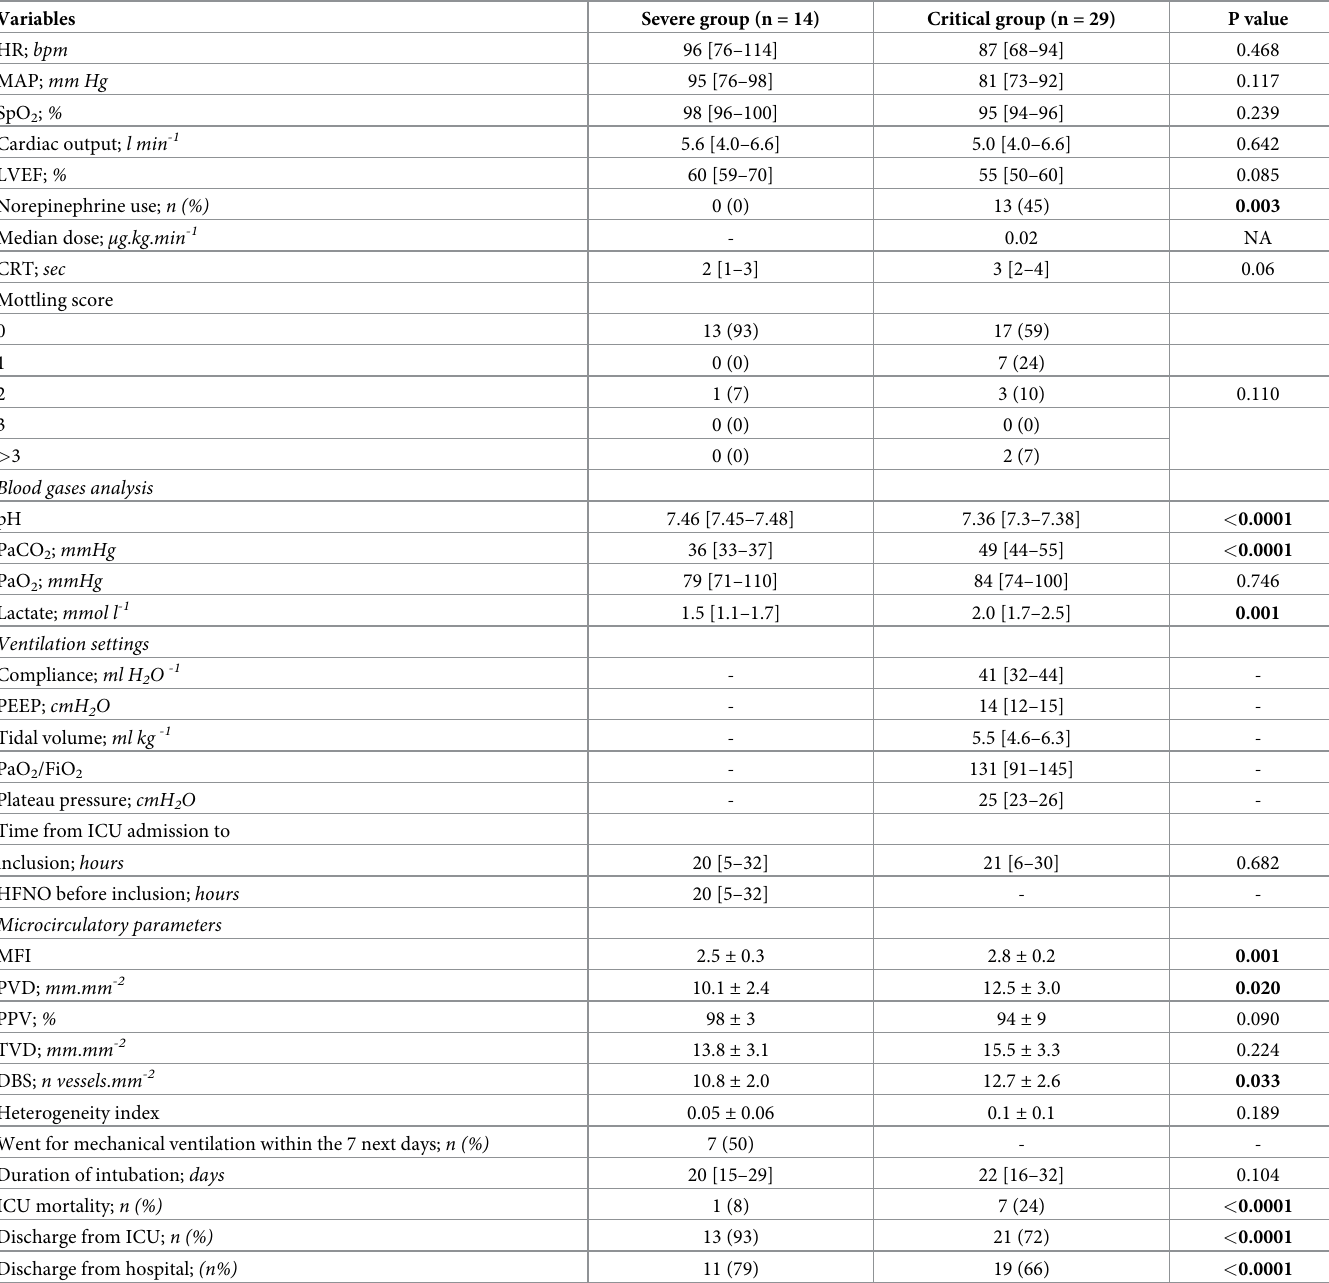
Table 2. Respiratory, biological and microcirculatory data between severe and critical